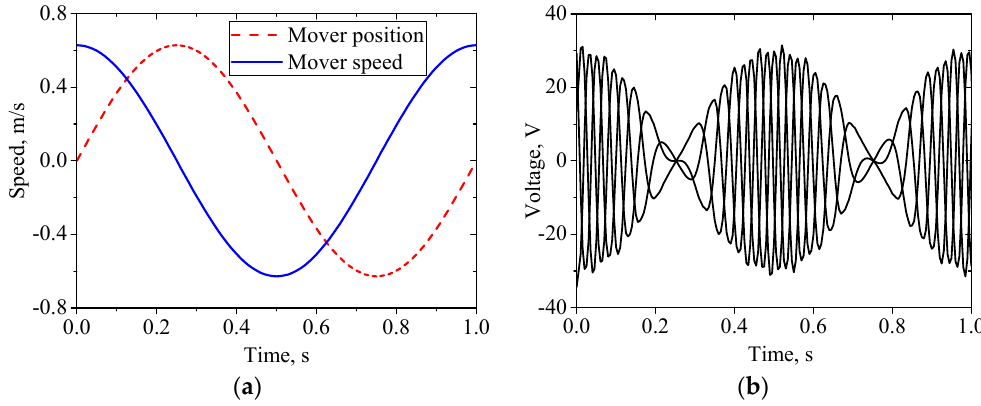
Figure 10. The translator position, translator speed, and back-EMF of MI-TLPMG at a sinusoidal speed of v ( t ) = 0.628cos ( 6.28 t ) : ( a ) position and speed; ( b )